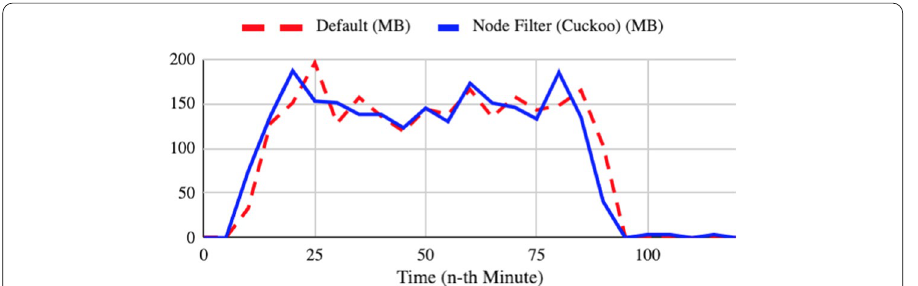
Fig. 16 Network bandwidth consumption (incoming) in megabytes (lower is better). The overhead of the proposed solution is negligible